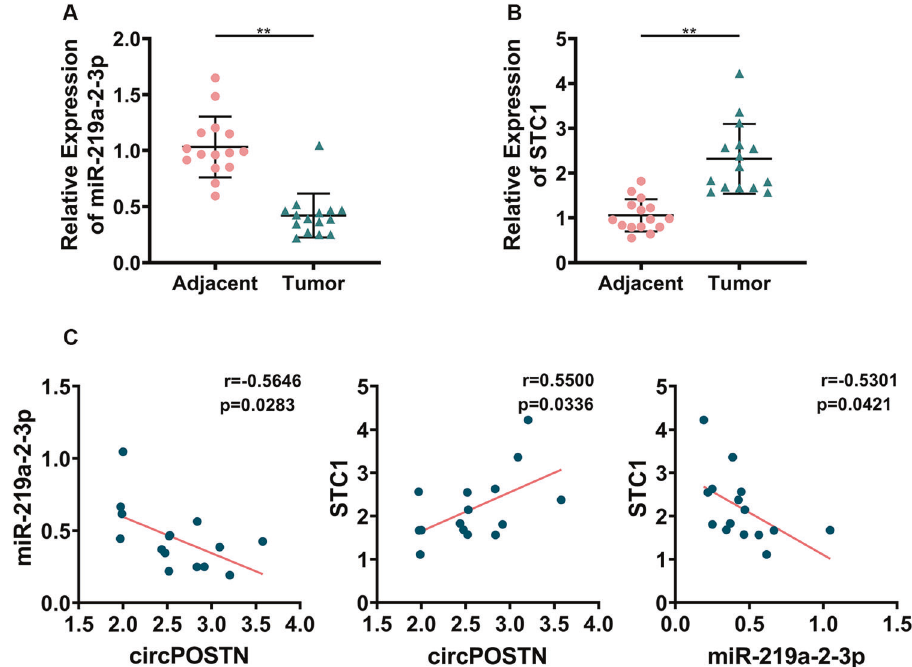
Fig. 8 CircPOSTN sponges miR-219a-2-3p and upregulates STC1 expression in GBM clinical samples. The expression level of miR-219a-2-3p ( A ) and STC1 ( B ) were compared by quantitative RT-PCR in 15 pairs of GBM tissues and the corresponding adjacent normal tissues. C Pearson ’ s correlation analysis between the circPOSTN and miR-219a-2-3p (left panel; Pearson ’ s r = − 0.5646), circPOSTN and STC1 (center panel, Pearson ’ s r = 0.5500), and miR-219a-2-3p and STC1 (right panel, Pearson ’ s r = − 0.5301) in 15 GBM clinical samples. Data are presented as the mean ± SD. ** P <